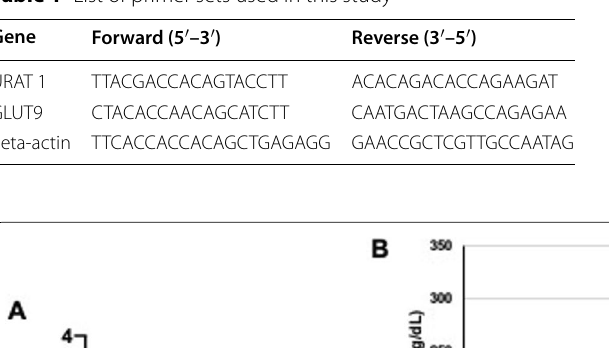
S.E.M.; n 5; * p < 0.05 versus C and C ± =